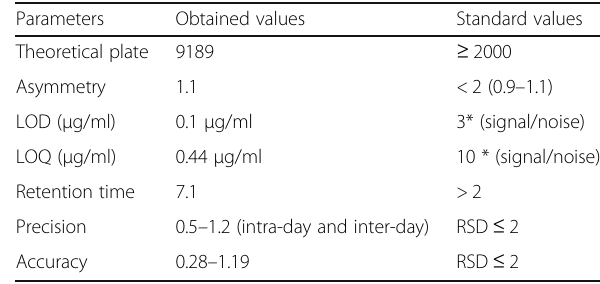
Table 6 Precision of the assay for naringenin in rat brain Conc taken